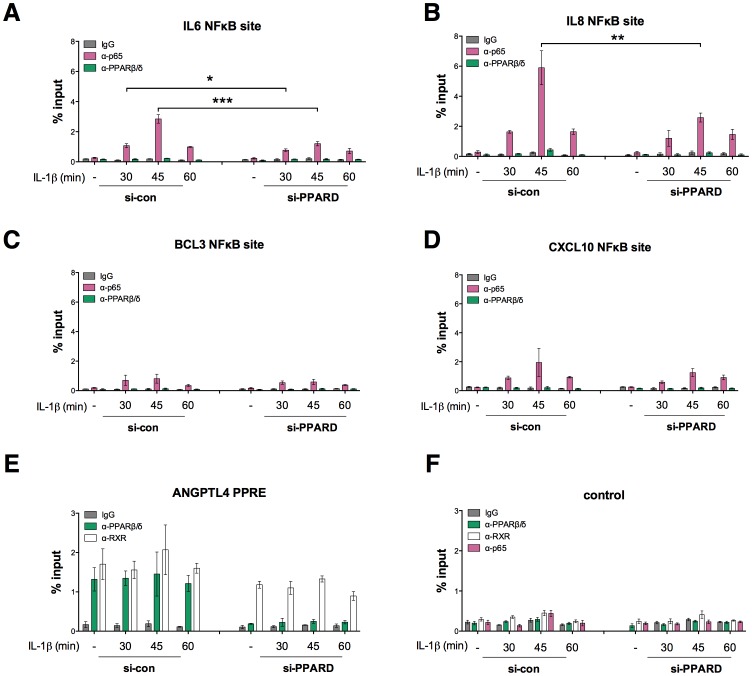
Modulation of p65 binding to NFκB target genes in vivo by PPARβ/δ.HeLa cells were treated with IL-1β and siRNAs as indicated and ChIP assays were performed with antibodies against PPARβ/δ (green), RXR (white) or p65 (red) or control IgG (grey). PCR primers were designed to detect the NFκB binding sites of the IL6 (A), IL8 (B), BCL3 (C) and CXCL10 (D) genes, the triple-PPRE of the ANGPTL4 gene (E) or an irrelevant genomic control region (F). Relative amounts of amplified DNA in immunoprecipitates were calculated by comparison with 1% of input DNA. Results are expressed as % input and represent averages of triplicates (± S.D). ***, **, *significant differences between si-con and si-PPARD-treated cells (p<0.001, p<0.01, p<0.05 by t-test).